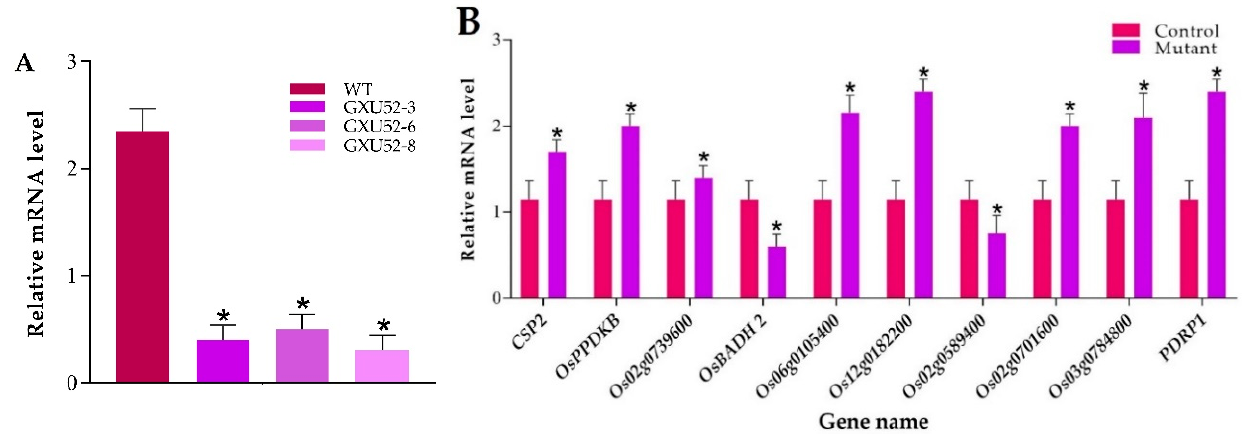
Figure 7. Real-time quantitative PCR validation of the OsSPL16 expression level in wild type (WT) and mutant lines, and ten selected differentially expressed proteins (DEPs) responsive genes under normal conditions. (A) Expression analysis of OsSPL16 in WT and mutant lines (B) Relative expression level of ten selected DEPs responsive genes. The data were analyzed by three independent repeats, and standard deviations were shown with error bars. Significant differences in expression level were indicated by “*”, Student’s t -test, p ≤ 0.01.